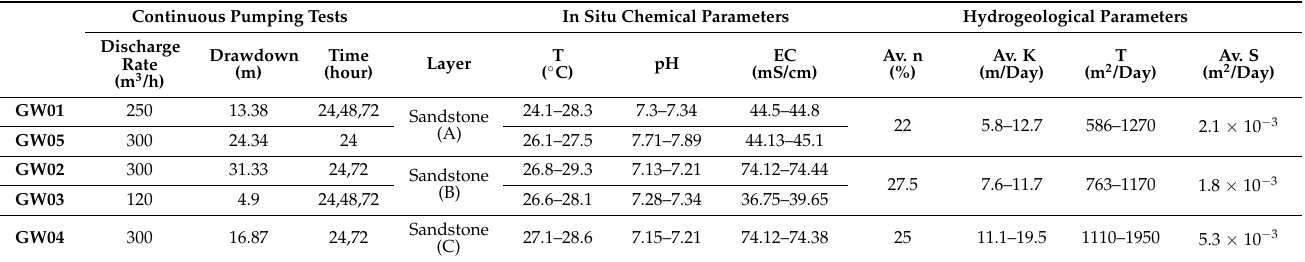
Table 1. Pumping test field data for three aquifers with in-situ chemical parameters and the estimated hydrogeological parameters.